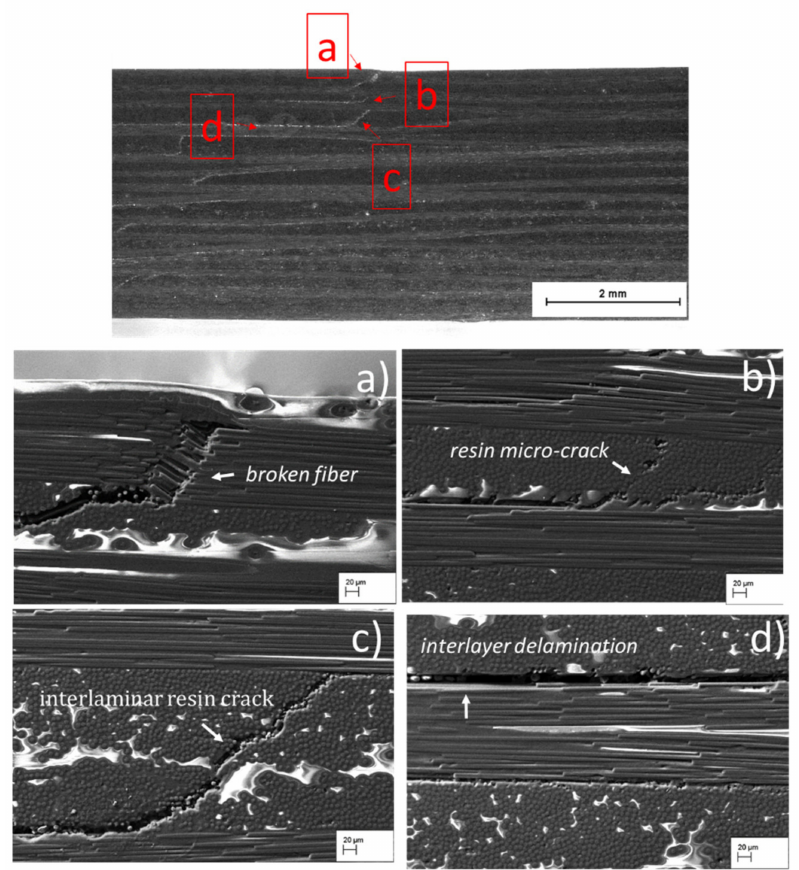
Figure 6. SEM macrograph of the SBS_120 sample cross section and high magnification SEM images of the sample showing some different areas: ( a ) fracture of the first fibres ply under the indenter; ( b ) micro- cracks between the 90 ◦ fibres; ( c ) interlaminar cracks along the 90 ◦ fibres; ( d ) interlaminar